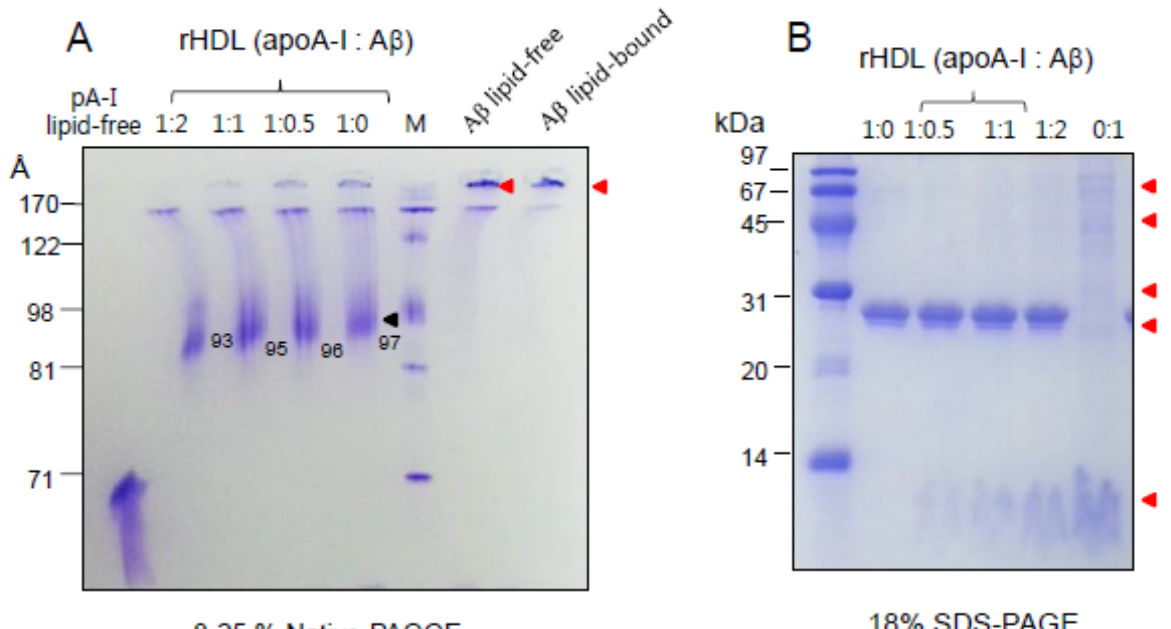
Figure 2. Electrophoretic patterns of apoA-I-rHDL containing A β with different molar ratios of apoA-I:A β (1:0, 1:0.5, 1:1, 1:2). ( A ) Each rHDL was migrated on an 8–25% native polyacrylamide gradient gel electrophoresis (PAGGE) without denaturation of proteins. Black arrowhead indicates major band of rHDL containing apoA-I. ( B ) Electrophoretic patterns of each rHDL with increasing amount of A β (18% SDS-PAGE). Red arrowheads indicate aggregated bands of A β